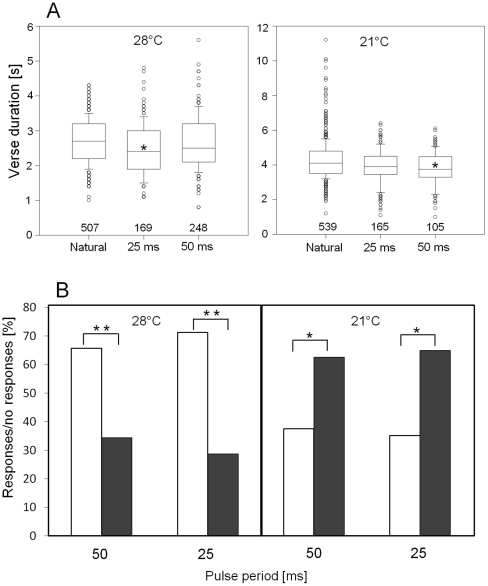
Response to playback of repetitive ultrasound pulses to singing tettigoniids.(A) Average verse duration of T. cantans males with and without repetitive ultrasound stimulation (25 ms and 50 ms pulse repetition period). Numbers in A represent the number of verses in each group. A significant difference (p<0.05) of stimulated verse durations from natural verse durations is indicated by *. B) Response of T. viridissima males to ultrasound stimulation in the form of song pausing (white bars) and the lack of such a response (black bars). 28°C: N = 131 (50 ms), N = 115 (25 ms); 21°C: N = 40 (50 ms), N = 38 (25 ms). All data was obtained from 8 T. cantans and 7 T. viridissima males. p<0.05 is indicated by *, p<0.001 is indicated by **; Upper and lower box limits in A represent 25 and 75 percentile and whiskers 10 and 90 percentile. Outliers are indicated by circles.